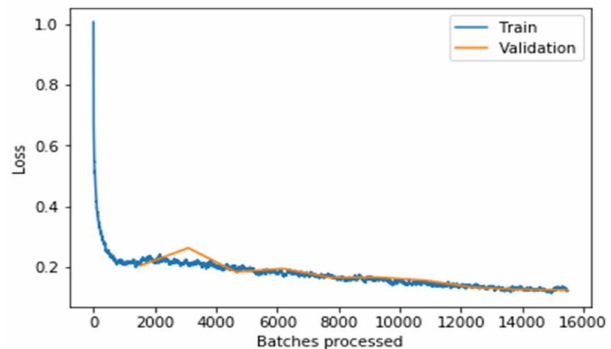
Figure 10. Loss associated with batches processed before fine-tuning the model.